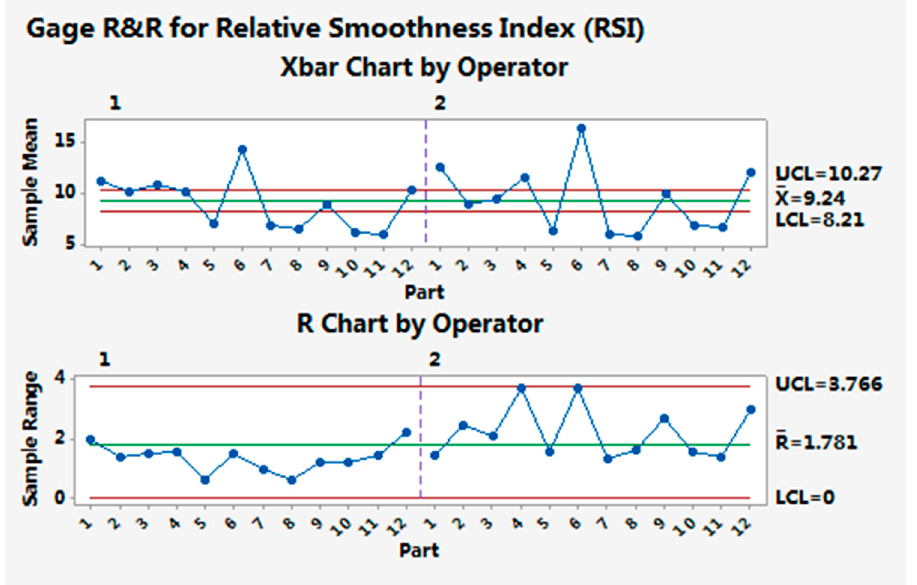
Figure 15. Gage capability result for the relative smoothness index (RSI).